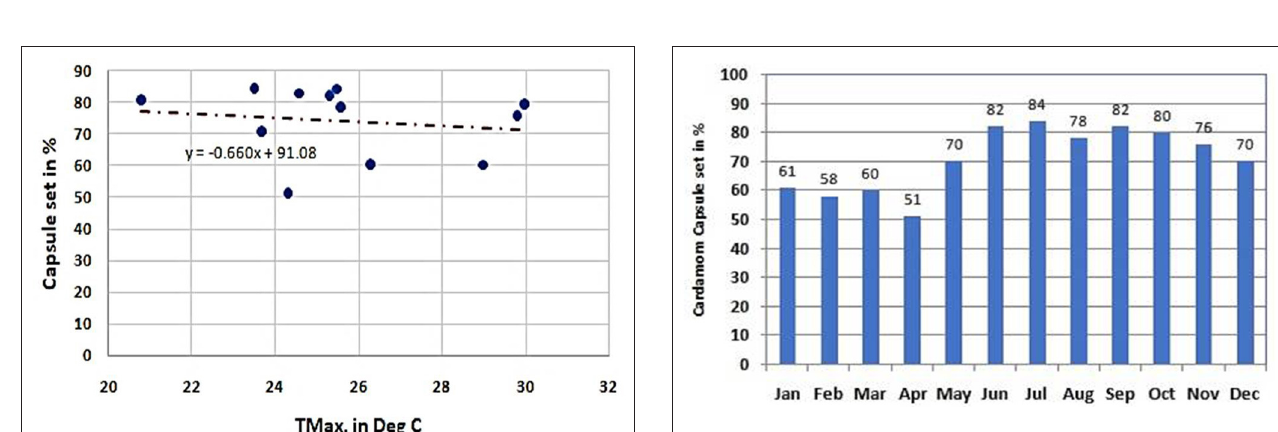
FIGURE 7 | Percentage capsule set vs.